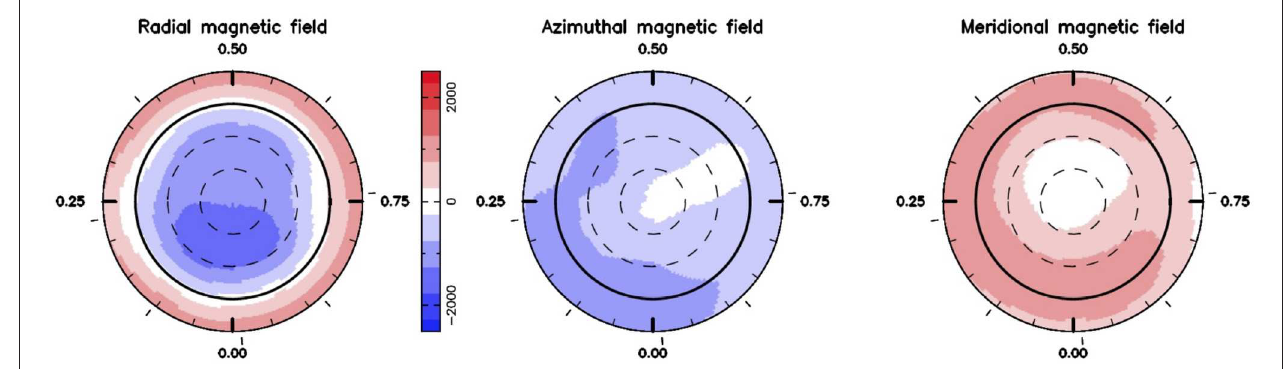
FIGURE 5 | Magnetic field map of the surface of the known jet source AA Tau. The field strength, shown by the colored scale, is in gauss for the radial, azimuthal and meridional components which are shown as a function of stellar phase. From Donati et al. (2010) reproduced with permission c